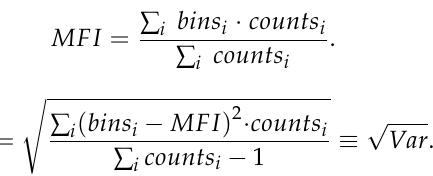
Table 6. MFI and SD of Cyto ‐ Trol ® and Vericell ® samples.